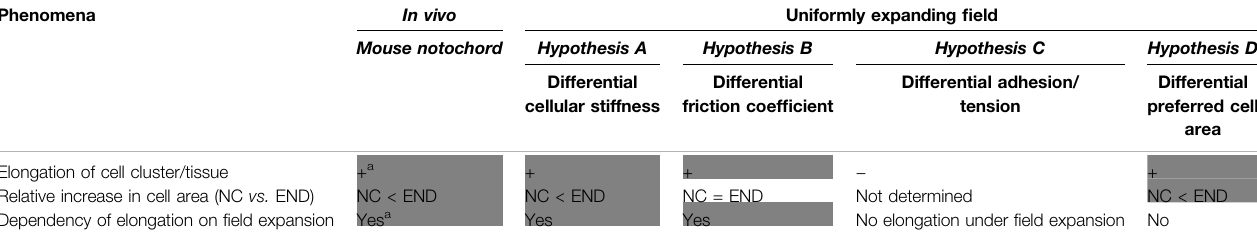
TABLE 1 | Summary of comparison of phenomena; in vivo vs. different models under uniformly expanding fi eld.